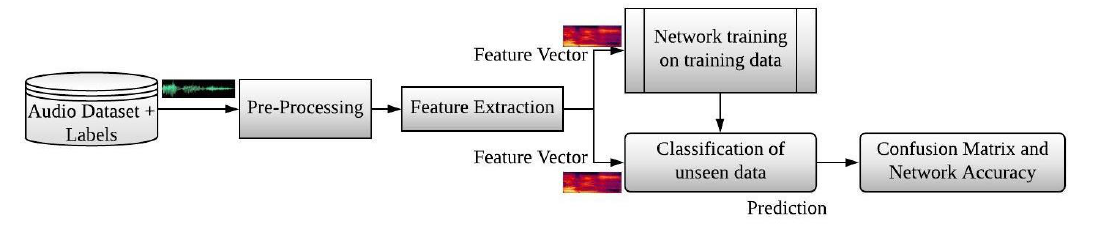
Figure 5. Proposed system